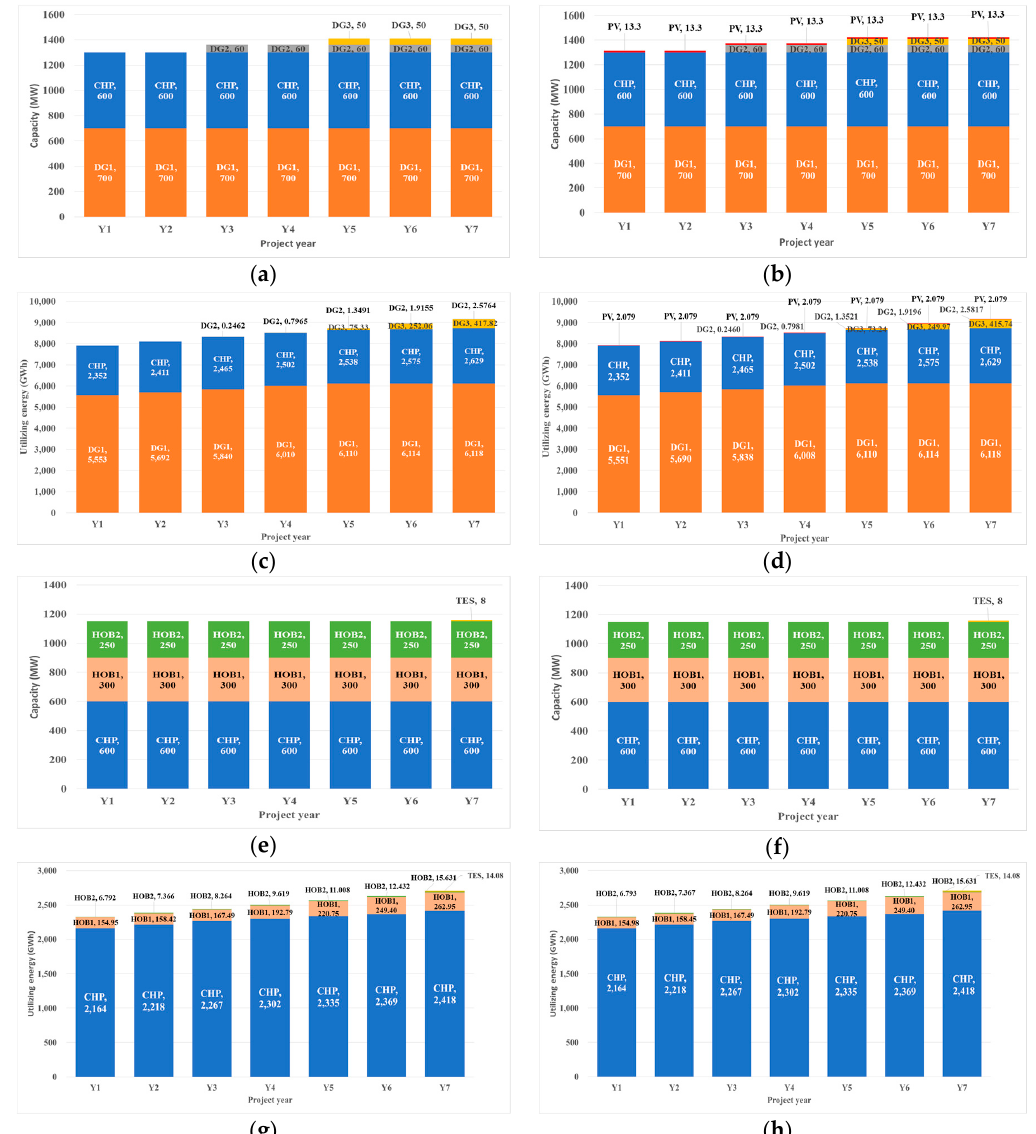
Figure 11. Results of planning schedules for Case 4: ( a ) Installed capacity of electricity resources without forced allocation of RES; ( b ) Installed capacity of electricity resources with forced allocation of RES; ( c ) Utilized energy of electricity resources without forced allocation of RES; ( d ) Utilized energy of electricity resources with forced allocation of RES; ( e ) Installed capacity of heat resources without forced allocation of RES; ( f ) Installed capacity of heat resources with forced allocation of RES; ( g ) Utilized energy of heat resources without forced allocation of RES; ( h ) Utilized energy of heat resources with forced allocation of RES.